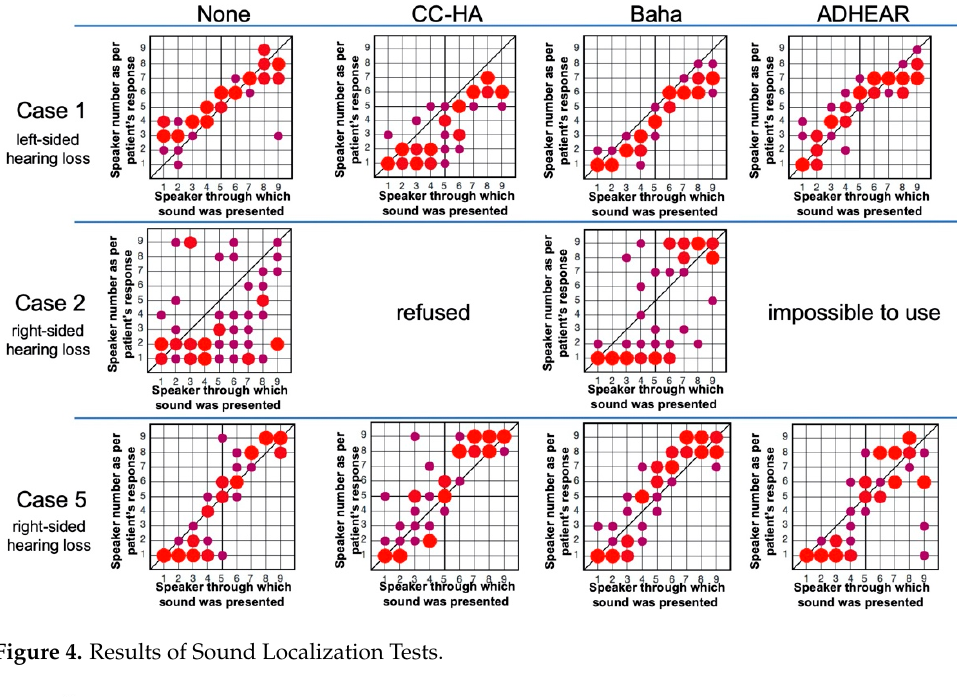
Figure 4. Results of Sound Localization Tests.